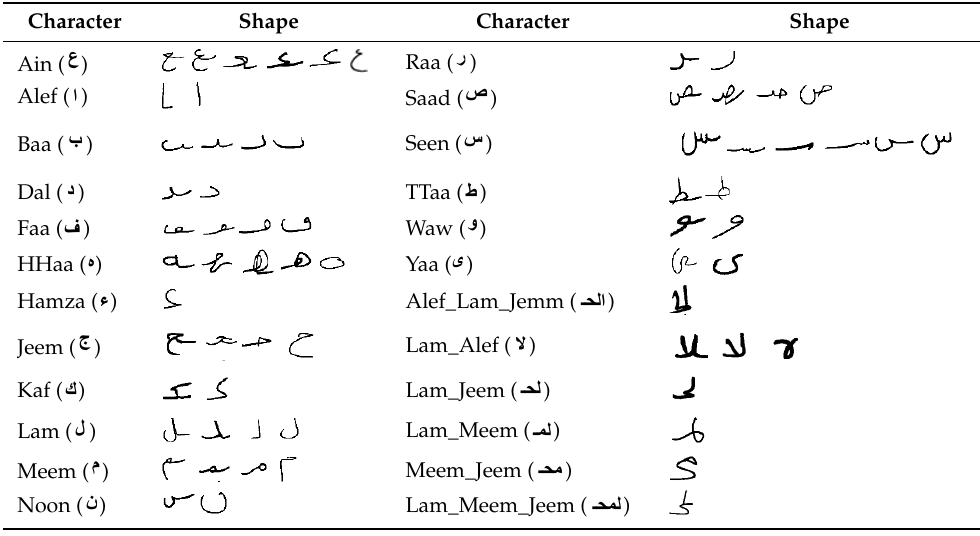
Table 6. HACDB database: 66 classes of individual shapes of Arabic handwritten characters, 16 classes of basic characters, and eight classes of overlapping characters.